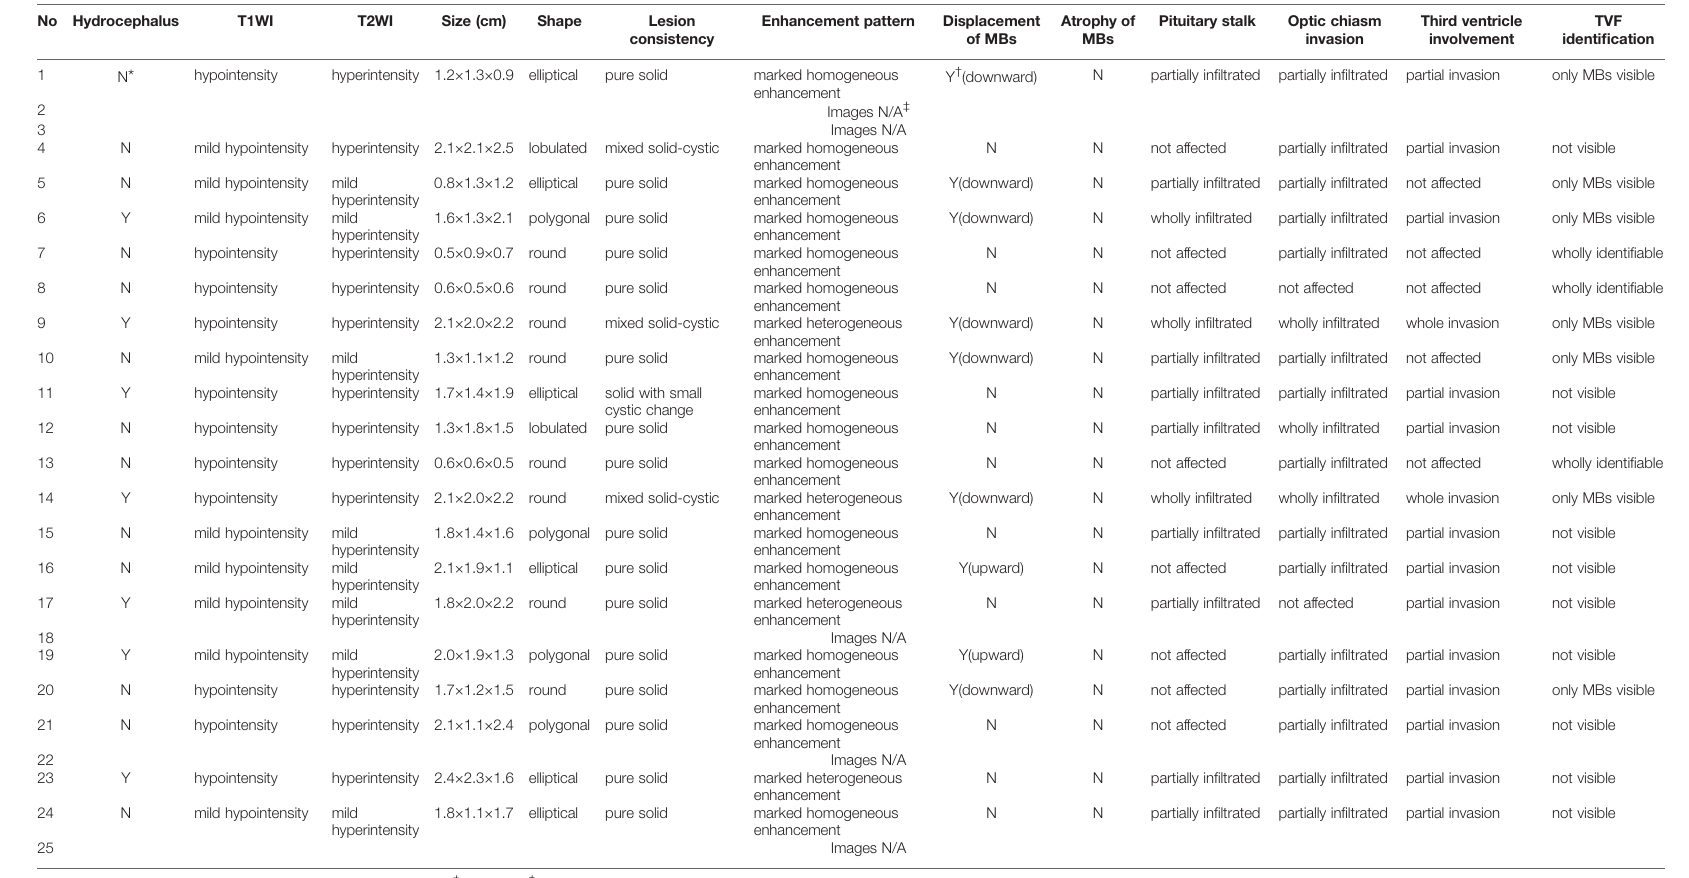
TABLE 2 | Summary of neuroradiological variables.